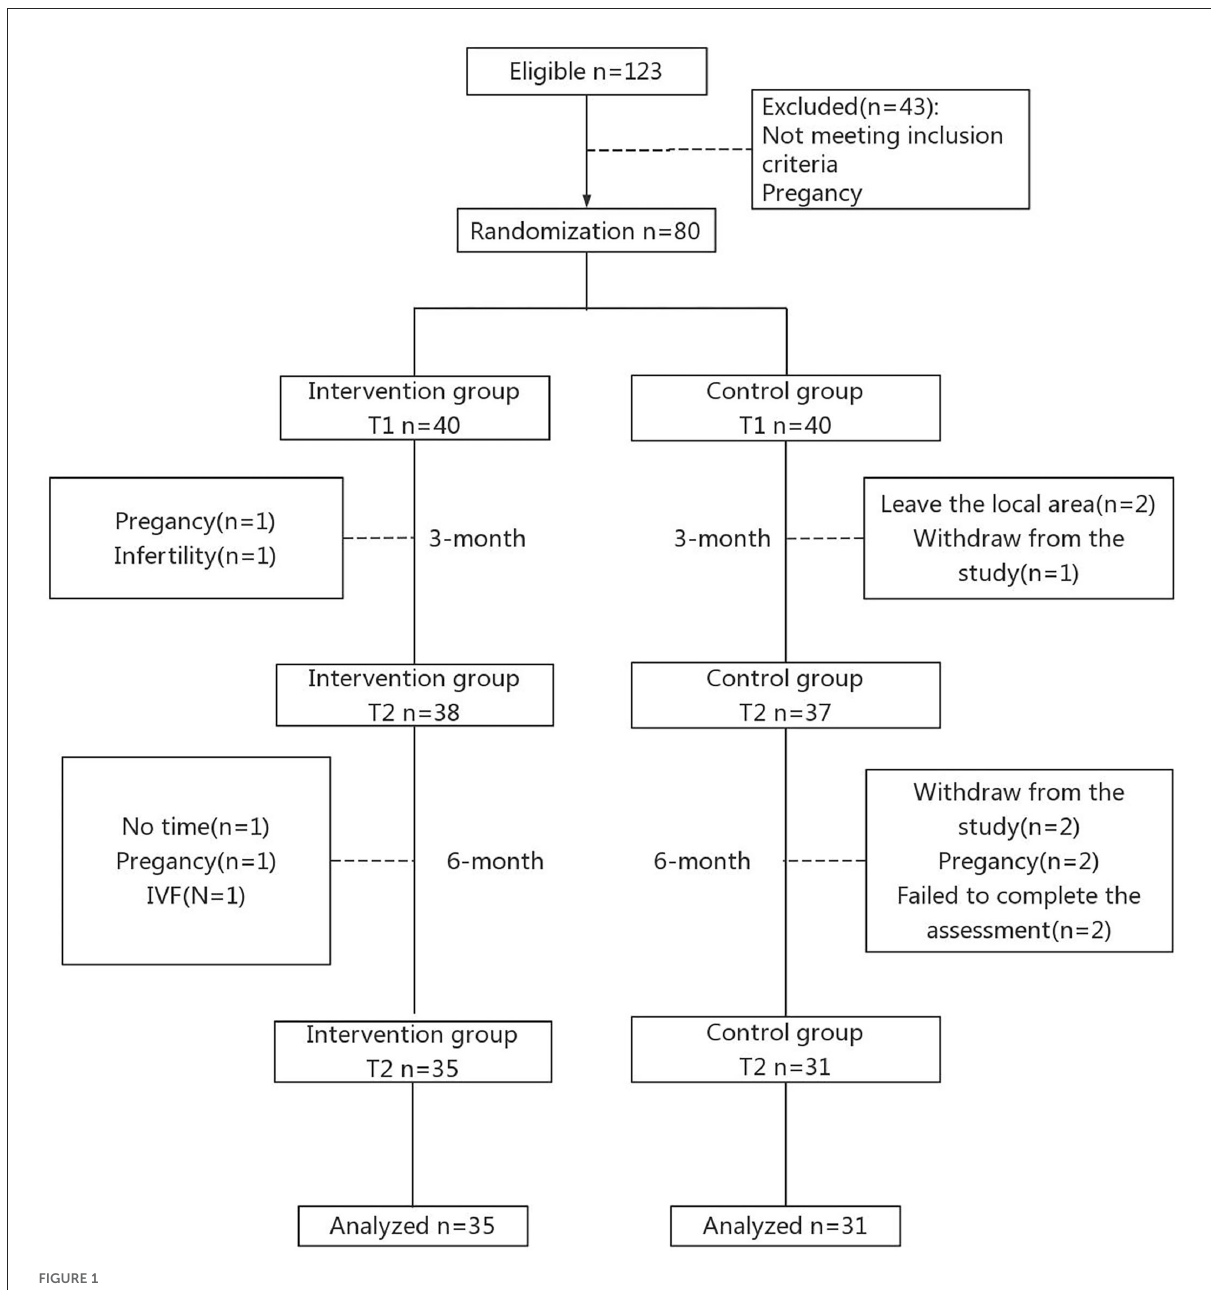
FIGURE1 Consort flow